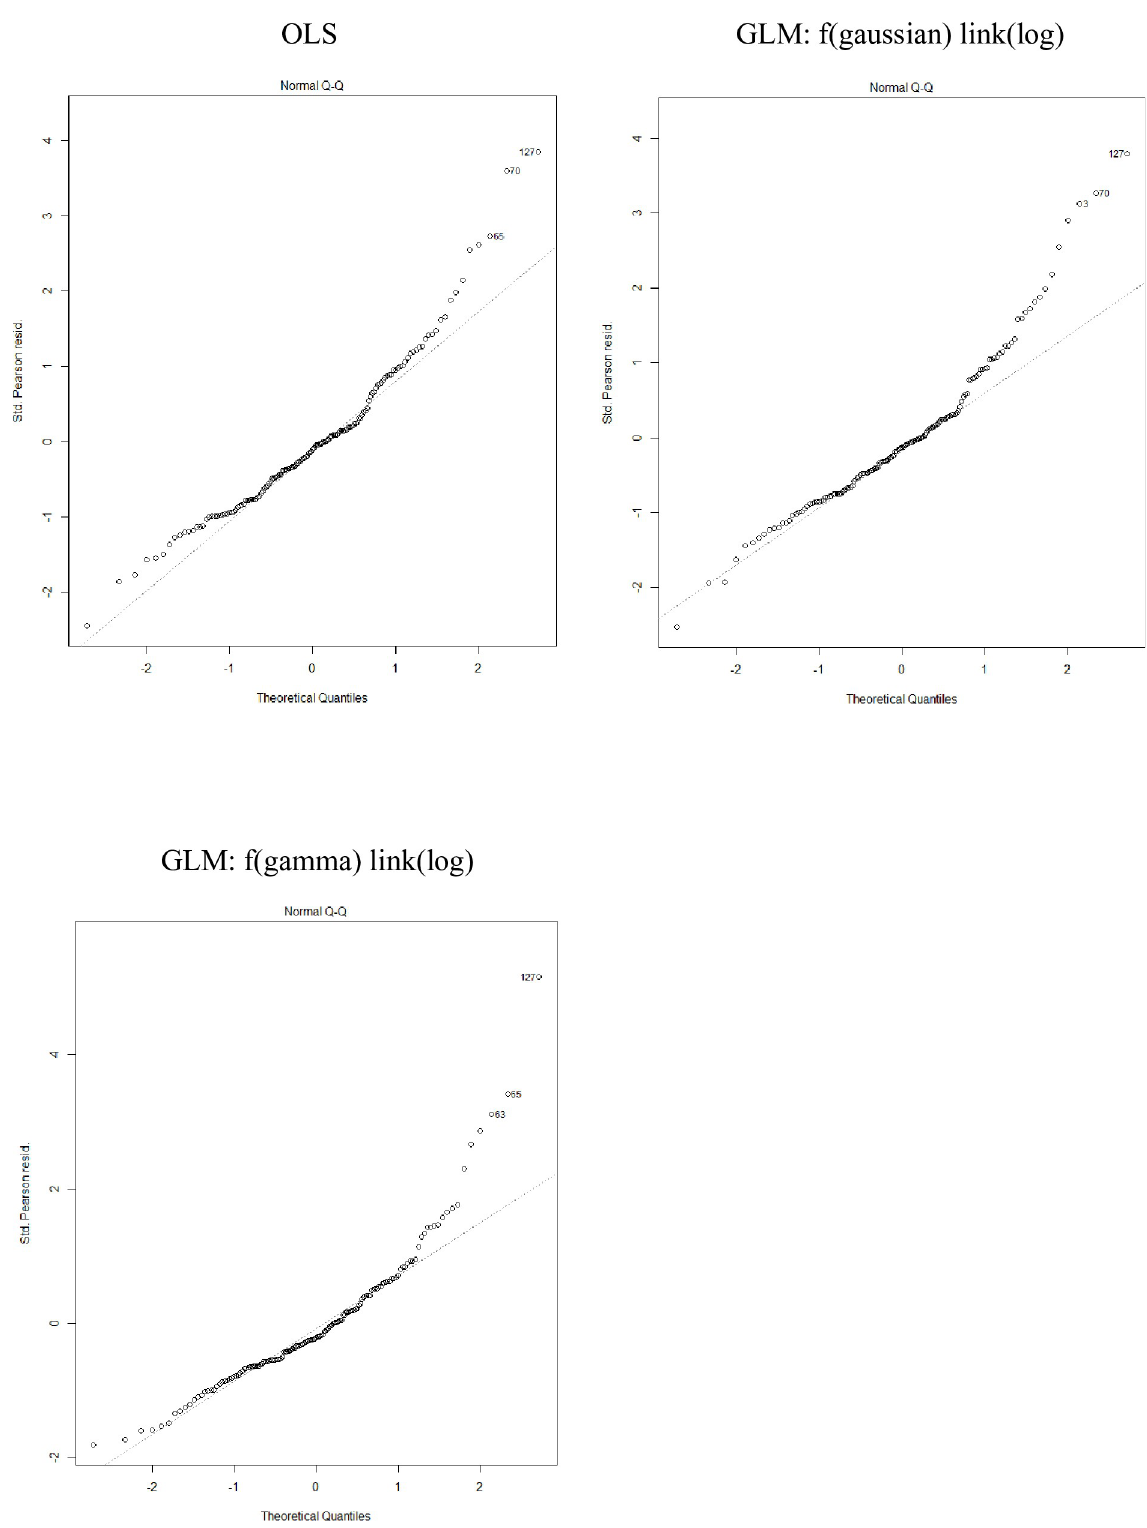
Fig 7. Q-Q plots for standardized deviance residuals for various American Samoa longline fishery trip cost models.